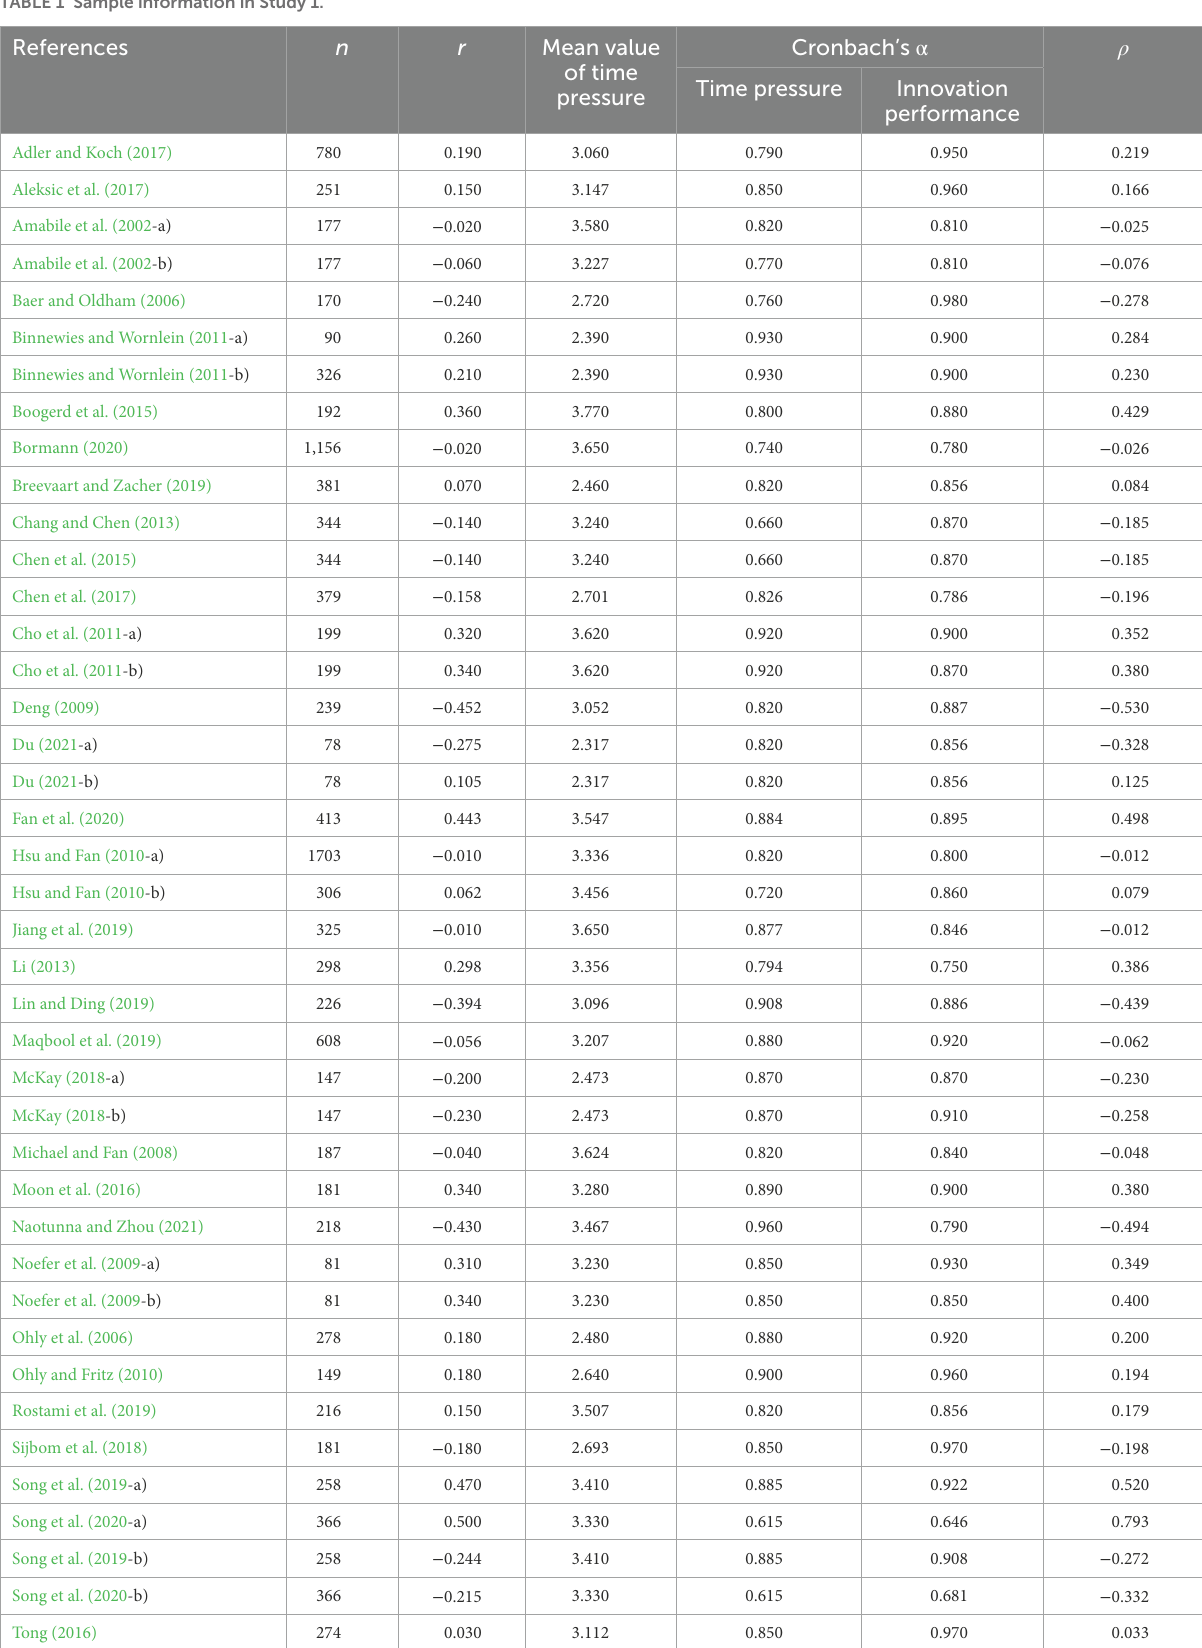
TABLE 1 Sample information in Study